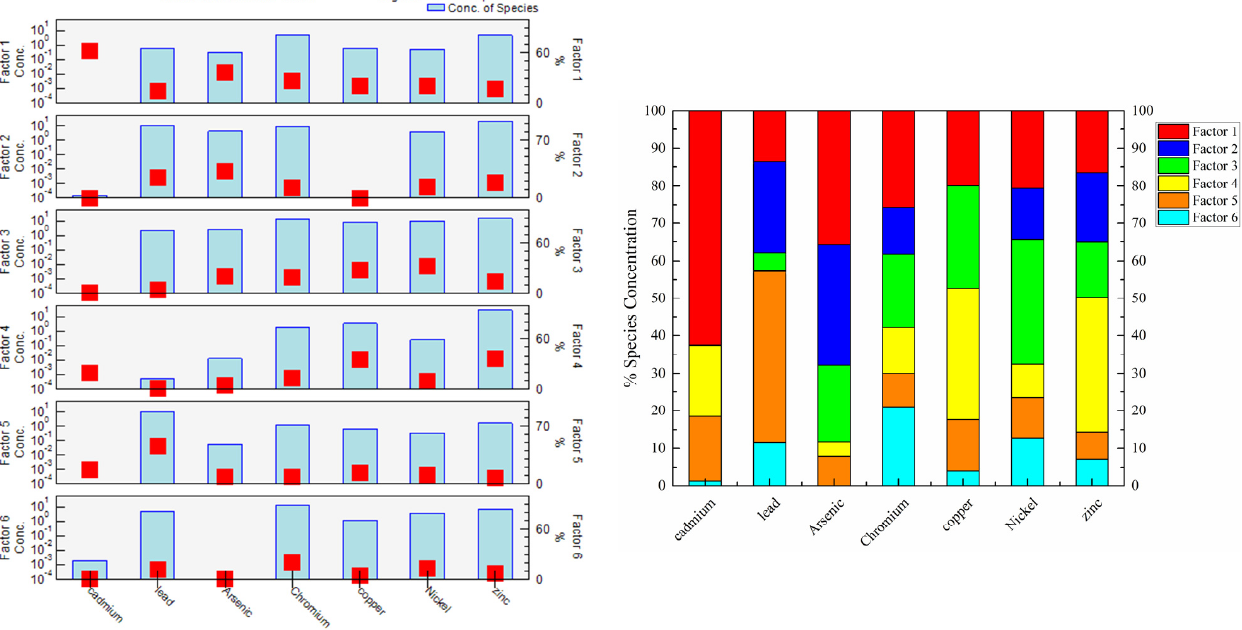
Figure 9. Source profiles from the PMF model and contribution of different factors to HM accumulation.